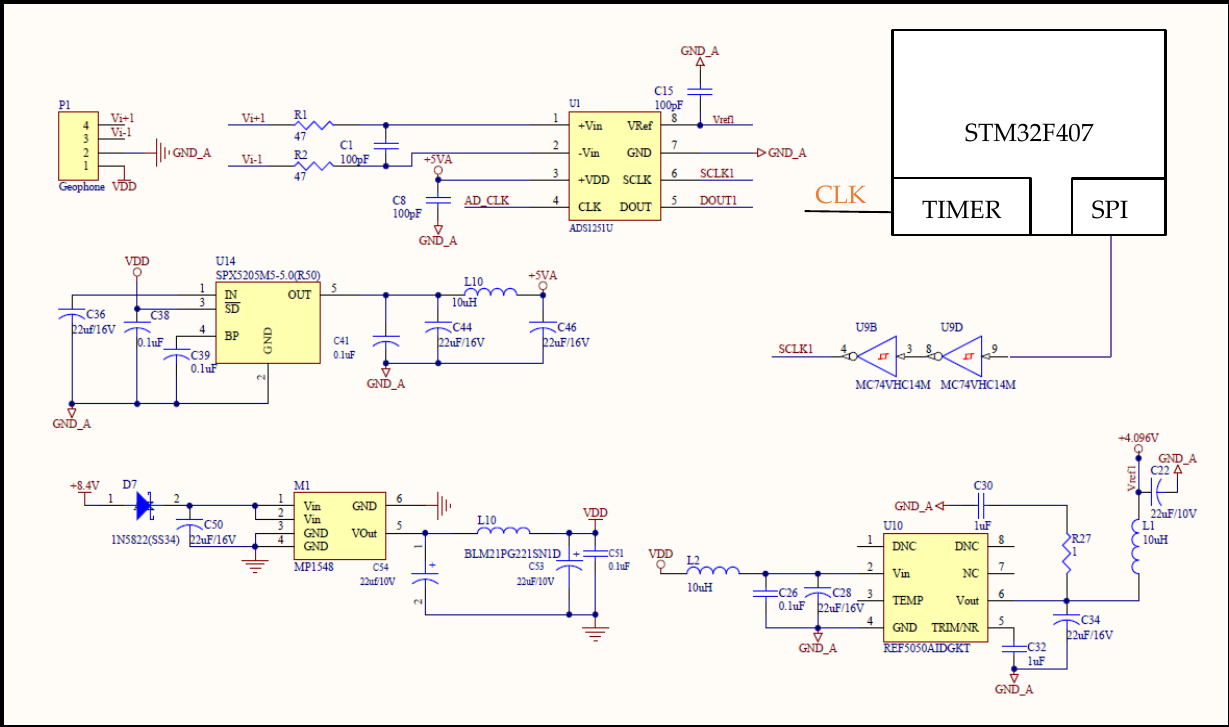
Figure 1. Schematic of the hardware peripherals used for the proposed seismograph. Only one of the ADCs is shown.